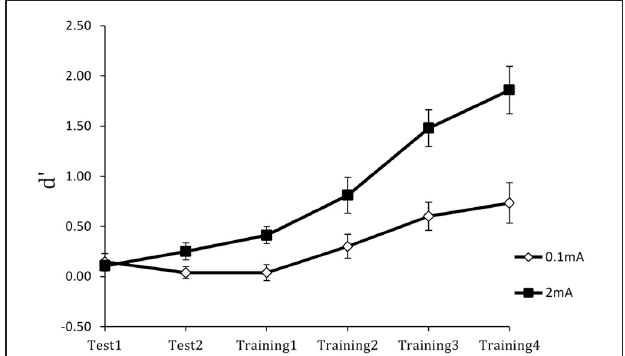
FIGURE 6 | Perceptual sensitivity ( d (cid:2) ) of threat detection across test and training blocks for active (2mA) and sham (0.1mA) brain stimulation groups. From Falcone et al.